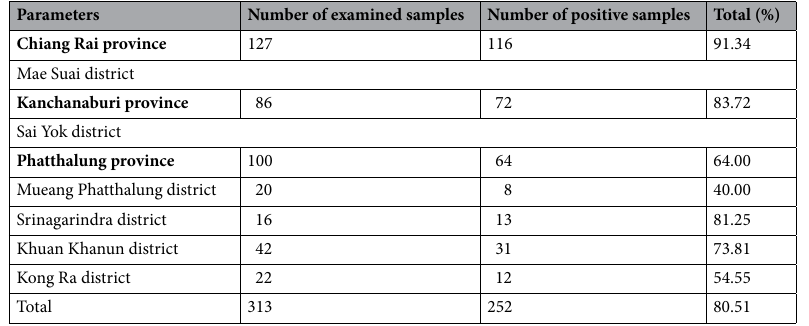
Table 1. Summary of L. sabrazesi infection in chickens from Chiang Rai, Kanchanaburi and Phatthalung provinces analyzed by PCR